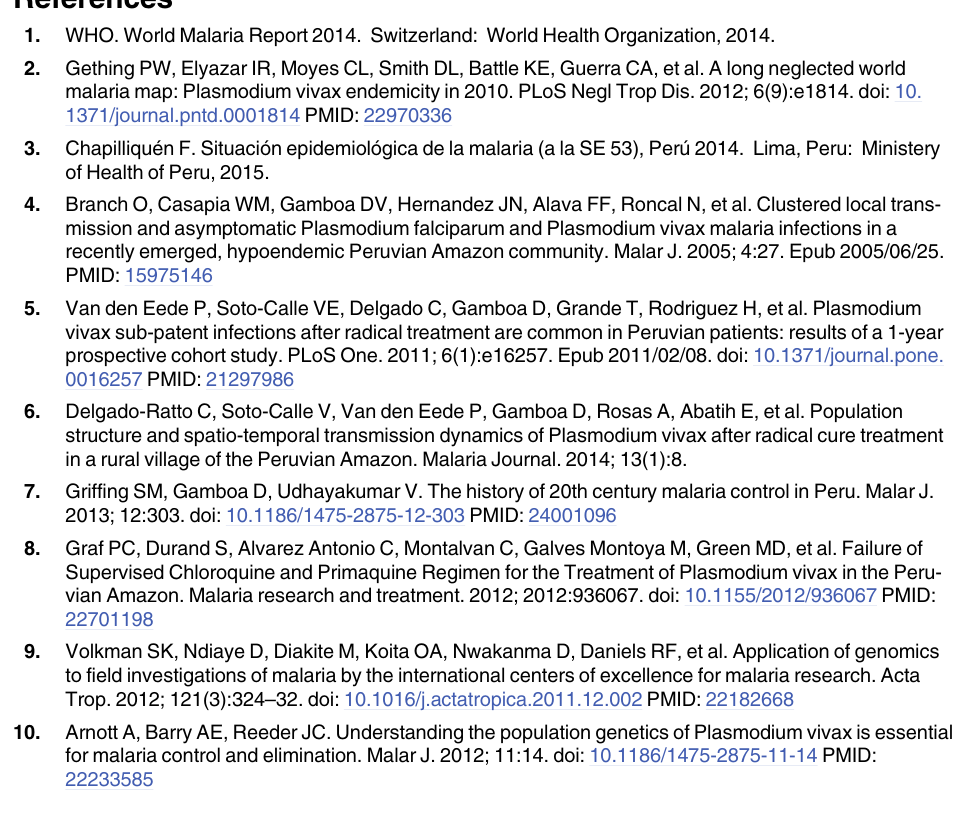
S2 Fig. Detection of hierarchical structure in one of the clusters detected in the initial STRUCTURE